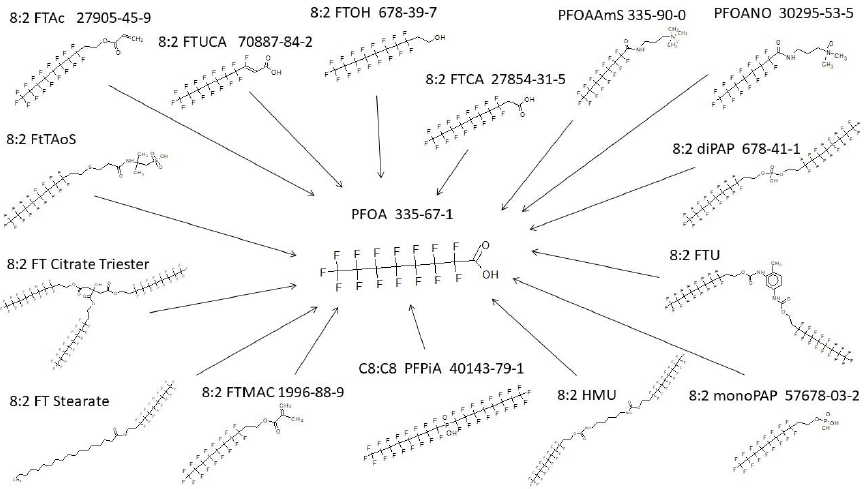
Figure 3. PFOA originating from a very diverse set of parent structures as found in the database.